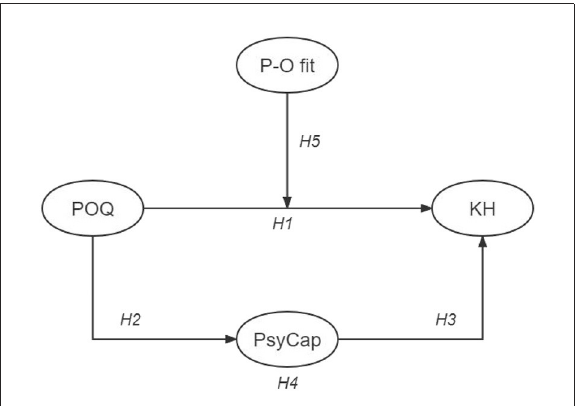
FIGURE1 Model of the theoretical